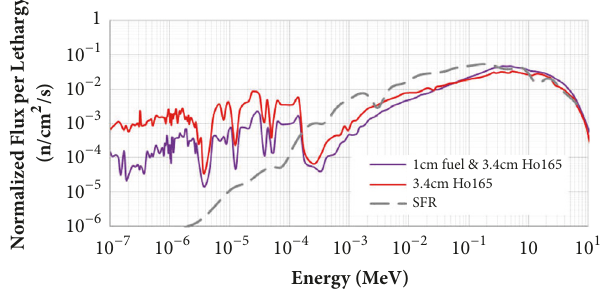
Figure 22: Effect on the neutron spectrum of 3.4 cm thick 165 Ho screen with and without 1cm fissile